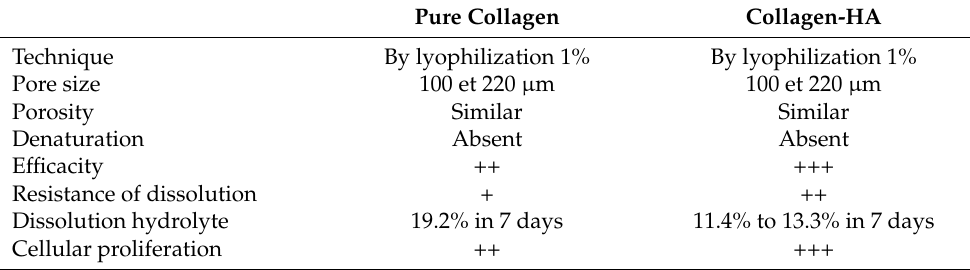
Table 4. Comparison of technical characteristics between scaffolds made with pure collagen vs. collagen-HA-based ones [219,227–229,234,235]. Pure Collagen Collagen-HA Technique By lyophilization 1% By lyophilization 1% Pore size 100 et 220 µ m 100 et 220 µ m Porosity Similar Similar Denaturation Absent Absent Efficacity ++ +++ Resistance of dissolution + ++ Dissolution hydrolyte 19.2% in 7 days 11.4% to 13.3% in 7 days Cellular proliferation ++